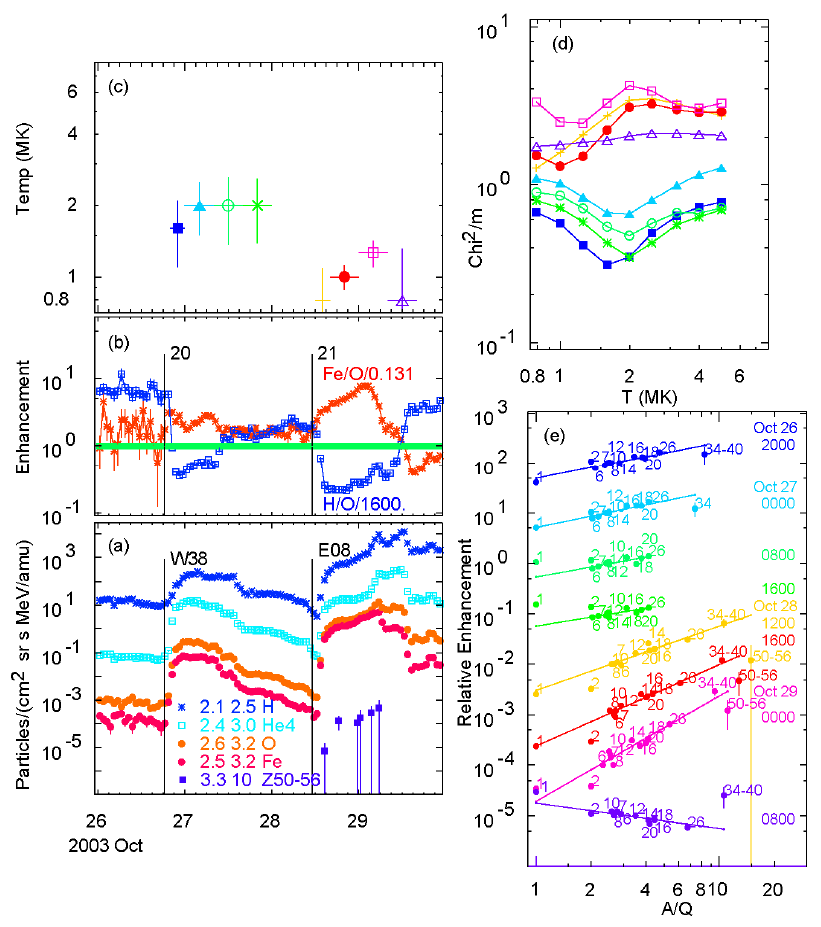
Figure 6. Analysis of the 26 and 28 October 2003 SEP events: ( a ) Intensities of H, He, O, Fe, and 50 ≤ Z ≤ 56 ions vs. time. ( b ) Normalized abundance enhancements H / O and Fe / O vs. time. ( c ) Derived source temperatures vs. time. ( d ) χ 2 / m vs. T for each 8-hr interval. ( e ) Enhancements, labeled by Z , vs. A / Q for each eight-hr interval shifted × 0.1, with best-fit power law for elements with Z ≥ 6 extrapolated down to H at A / Q = 1. Colors correspond for the eight time intervals in (c), (d), and (e) and symbols in (c) and (d); times are also listed in (e). Event onsets are flagged with solar longitude in (a) and event number from [28,76] in (b). The 28 October event produced a ground-level event (GLE). Note in panel (d) of Figure 6 that the probable source temperature and fit is selected by the minimum in χ 2 . When the dependence upon A/Q is flat, i.e. the abundances are nearly coronal, T is